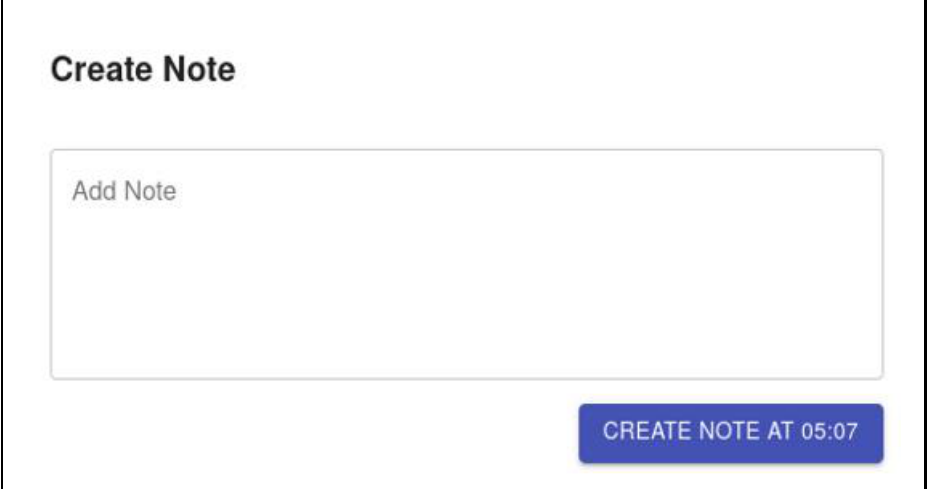
Figure 11. Note Creation Modal.